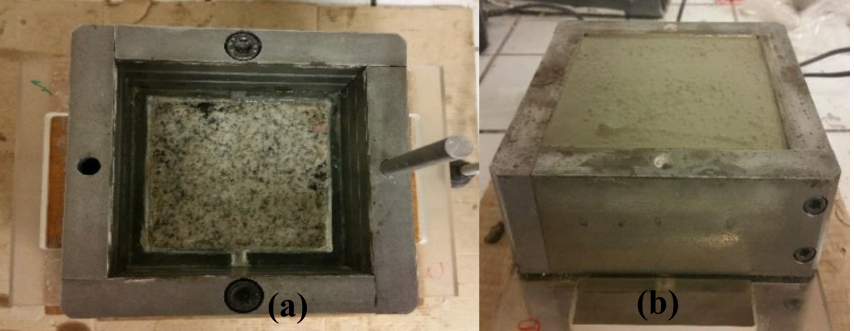
Figure 2. Sample preparation: ( a ) lower half shear box with granite; ( b ) upper half shear box with concrete.